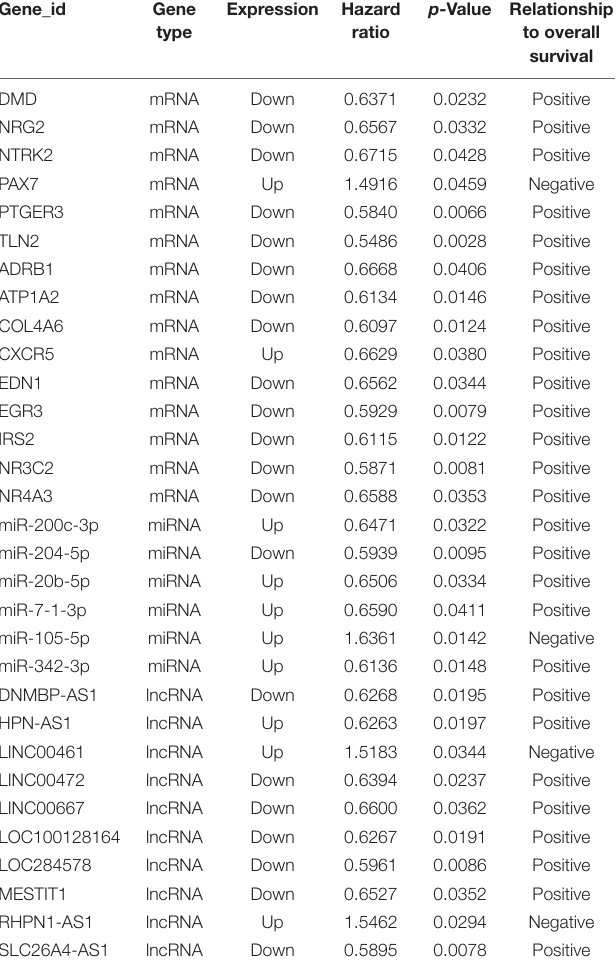
TABLE 2 | lncRNA/miRNA/mRNAs that were significantly related to overall survival in breast cancer